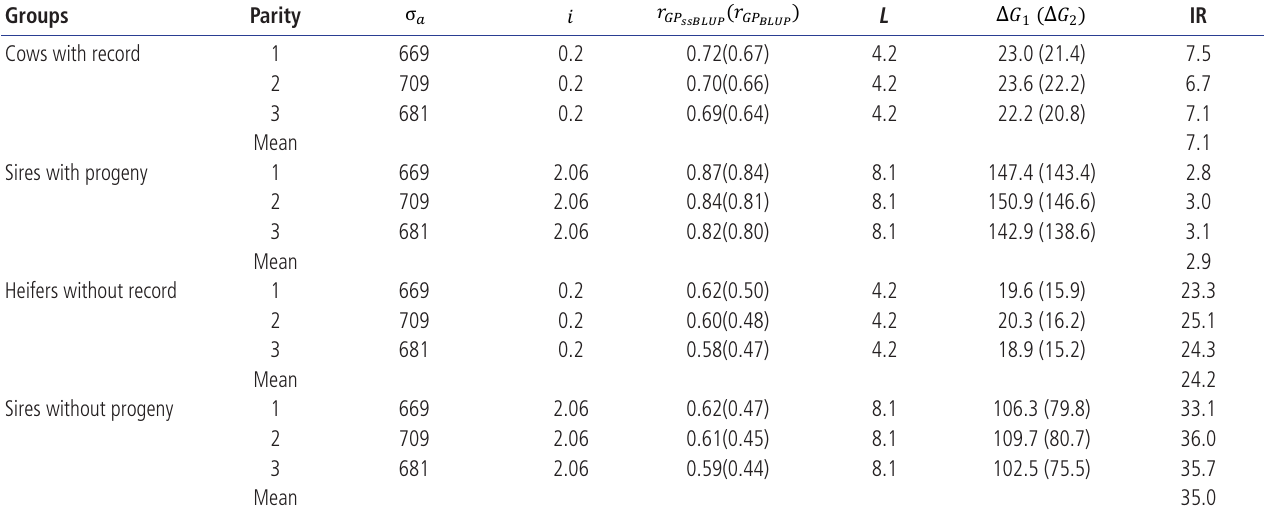
Tables 4. Genetic gains of milk yield (kg) per year by the selection method and group 388